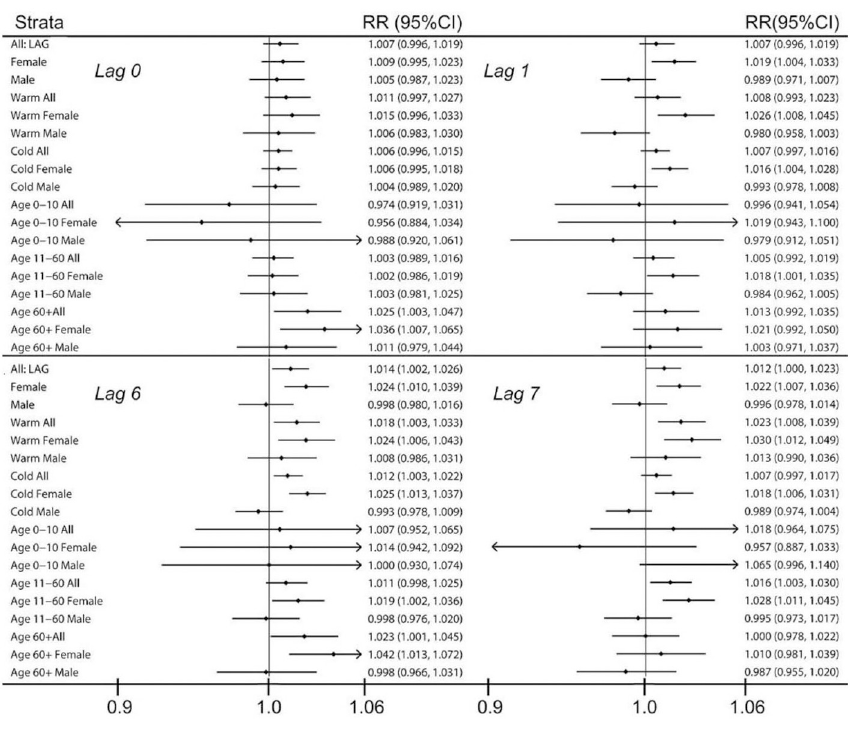
Fig 4. Relative risks (RR) and 95% confidence intervals (95%CI) for an increase in a one interquartile range (CO, IQR = 0.1 ppm). ED visits diagnosed with the ICD-10 codes G40-G47 for the entire study period in Toronto between 2004 and